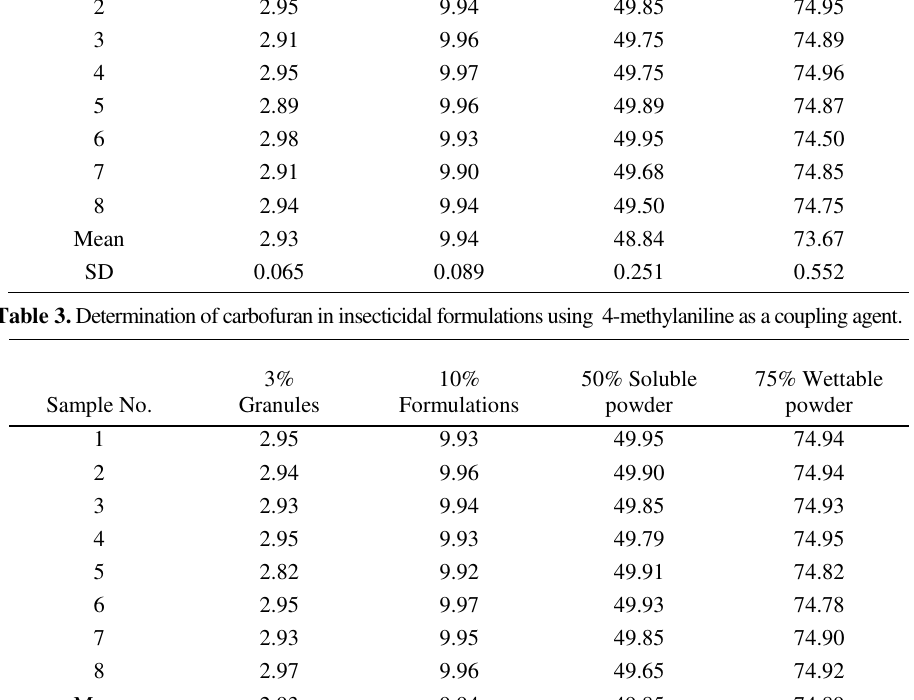
Table 2. Determination of carbofuran in insecticidal formulations using 4-bromoaniline as a coupling agent. Sample No.